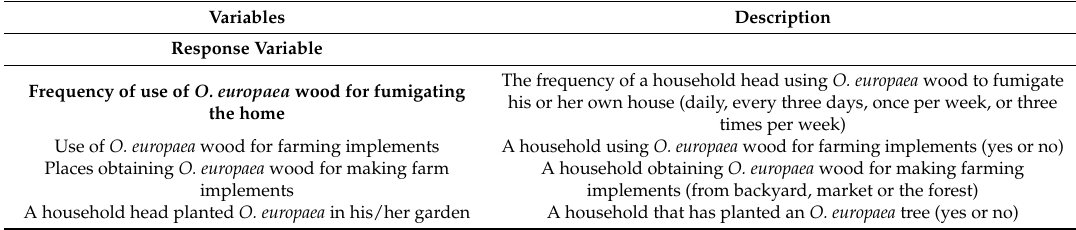
Variables Description